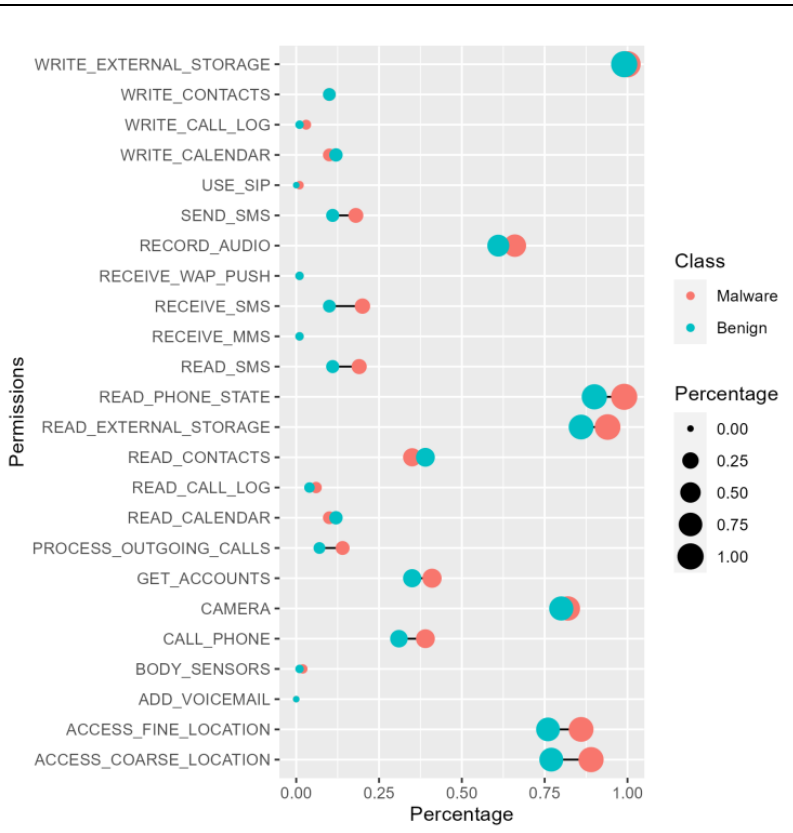
Figure 3. A total of 24 dangerous permissions in the percentages of malicious applications and benign applications, respectively. Table 6. Top 20 most common permissions in malicious and benign apps.